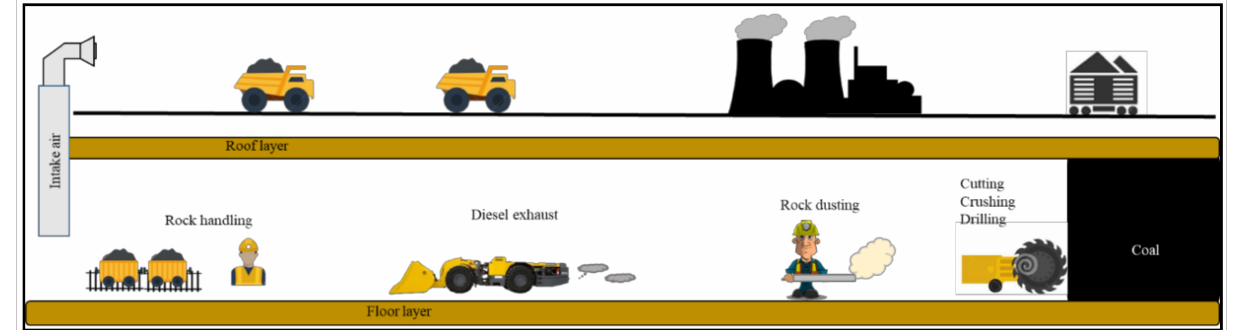
Figure 1. Major sources of RCMD in underground coal mines